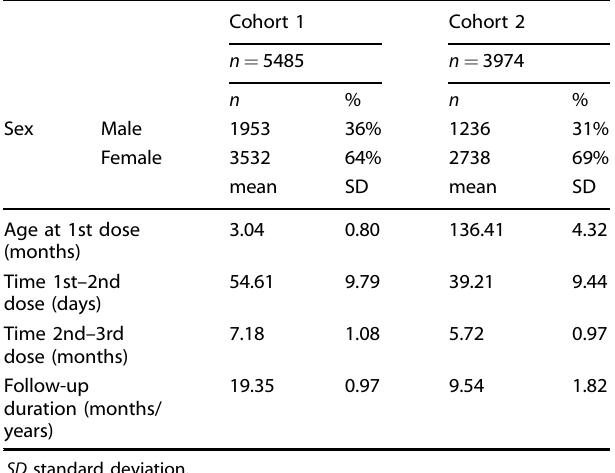
Table 1. Characteristics of the study population.